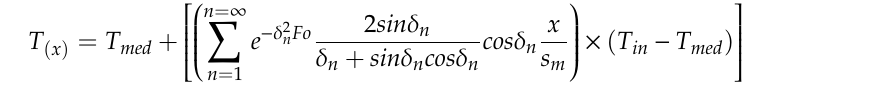
Figure 2. Heat flow in the Hot Mix Asphalt (HMA) layer and heat transfer during the cooling